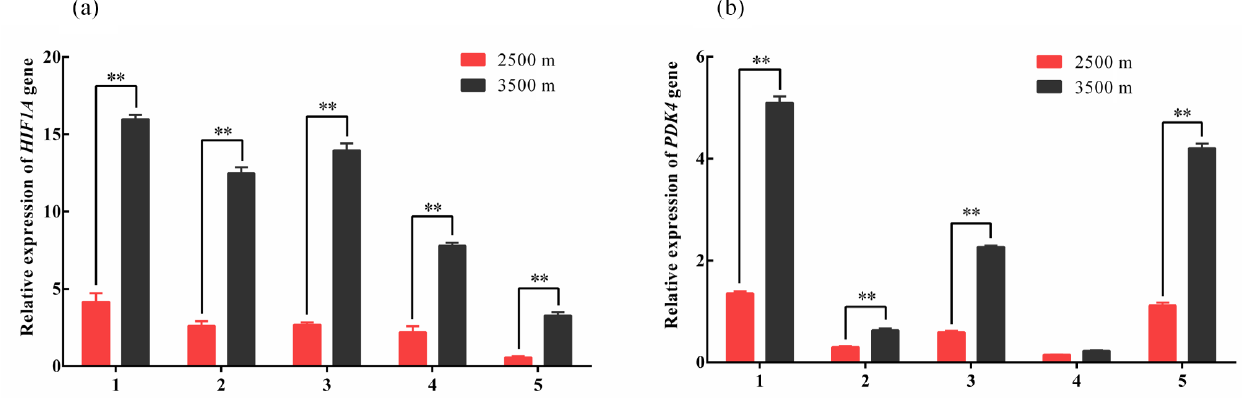
Figure 1. Relative expression levels of HIF1A (a) and PDK4 (b) mRNA in five tissues obtained from yak living at different altitudes. Note that heart (1), liver (2), lung (3), kidney (4), and longissimus dorsi (5) tissue homogenates were analyzed for mRNA expression. The expression values for the qPCR are given relative to the expression levels of the β -actin , GAPDH , and RPL19 gene. The bars represent the mean ± SEM from three independent biological replicates, each performed with three technical replicates. Asterisks denote significant differences: * P < 0 . 05; ** P < 0 . 01 .